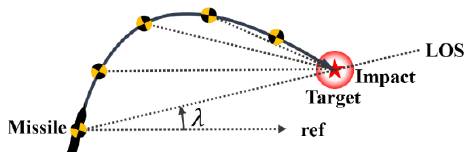
Figure 4. Conceptual diagram of proportional navigation guidance.